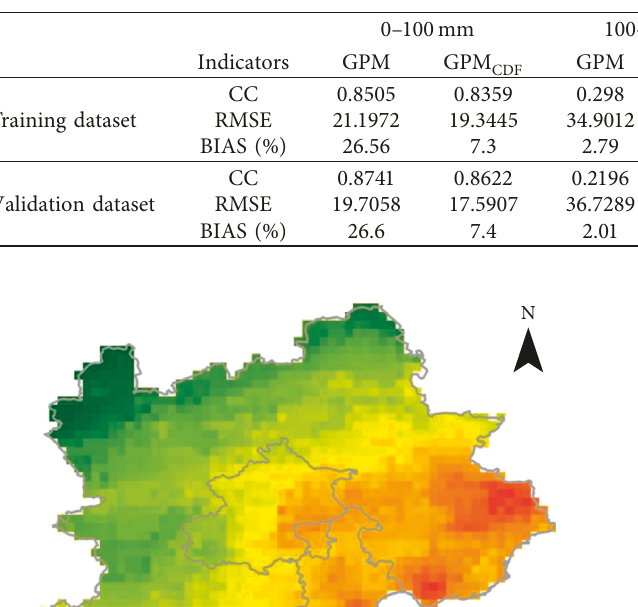
Table 7: CDF model verification results according to precipitation range.